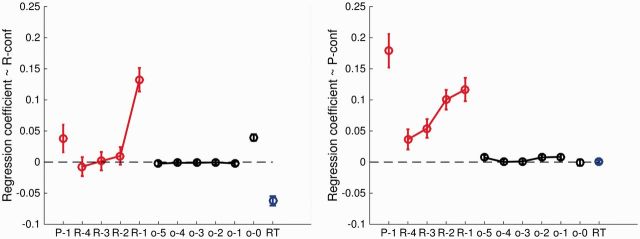
Regression coefficients predicting R-confidence (left panel) and P-confidence
(right panel) from features of previous trials. Coefficients are extracted from the
full model (Model 4) including all predictors to facilitate comparison across
judgment type. P = P-confidence; R = R-confidence; o = outcome; RT = response time.
Lag into the past is indicated by increasing indices (e.g. R-2 indicates the
R-confidence judgment made two trials previously). See Tables 1 and 2 for full details.